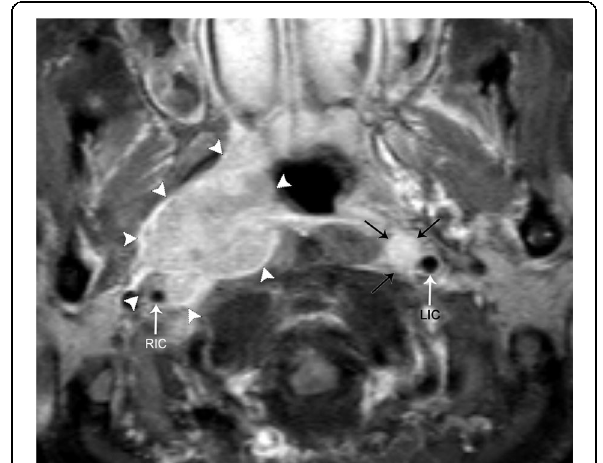
Fig. 22 Direct spread of non-HPV-associated squamous cell carcinoma into the carotid space. Axial contrast-enhanced, fat- suppressed T1 image demonstrates a large, avidly enhancing and infiltrating mass that invades the right carotid space (white arrowheads). The right carotid artery (RIC) is encased, narrowed, and laterally displaced when compared to the left internal carotid artery (LIC). Encasement of the carotid artery upstages the disease to T4b. There is also a left retropharyngeal lymph node (black arrows), just medial to the